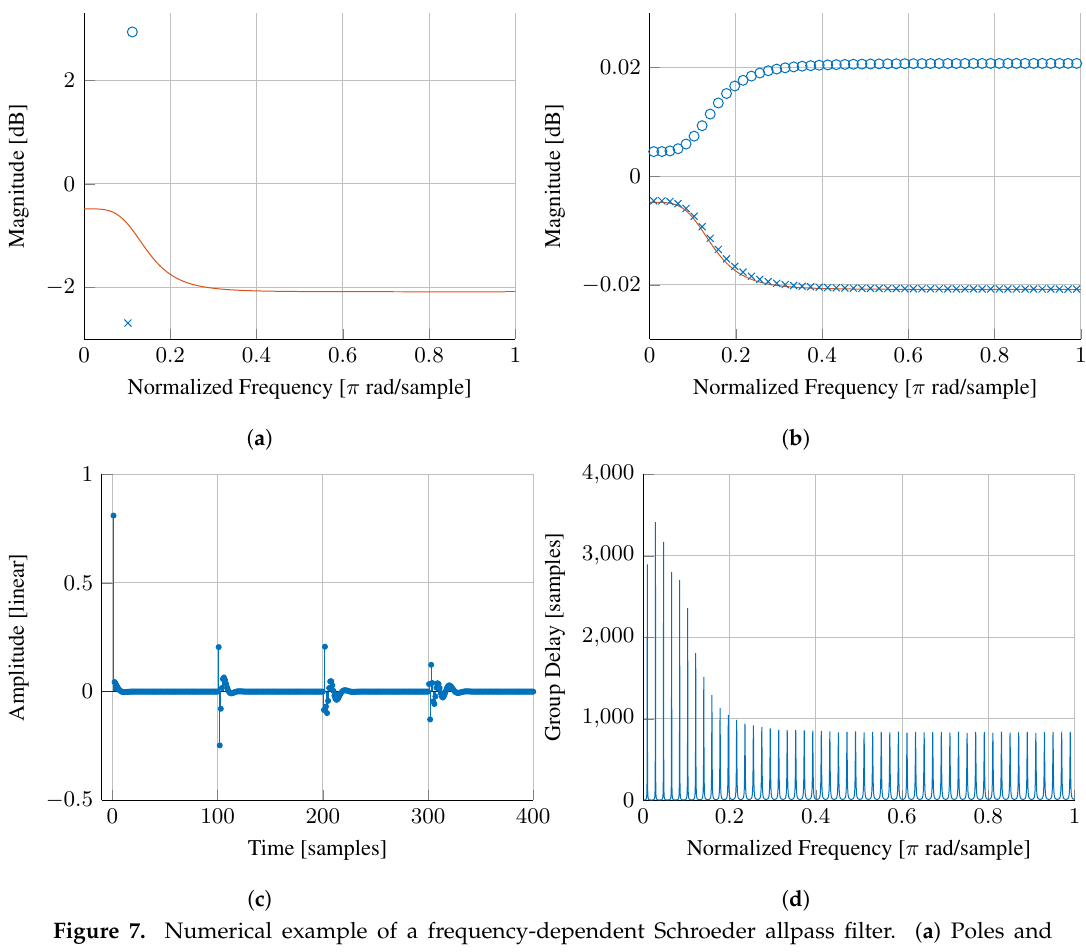
g ( e ı ω ) (solid red); ( b ) Poles and zeros of | | 1/ m (solid red); ( c ) Impulse response of g ( e ı ω ) | |